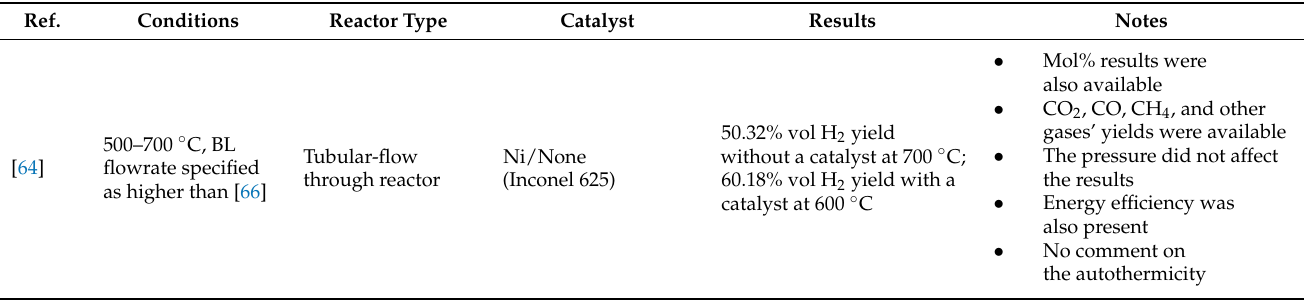
Table 5. Comparative table of the black liquor gasification studies